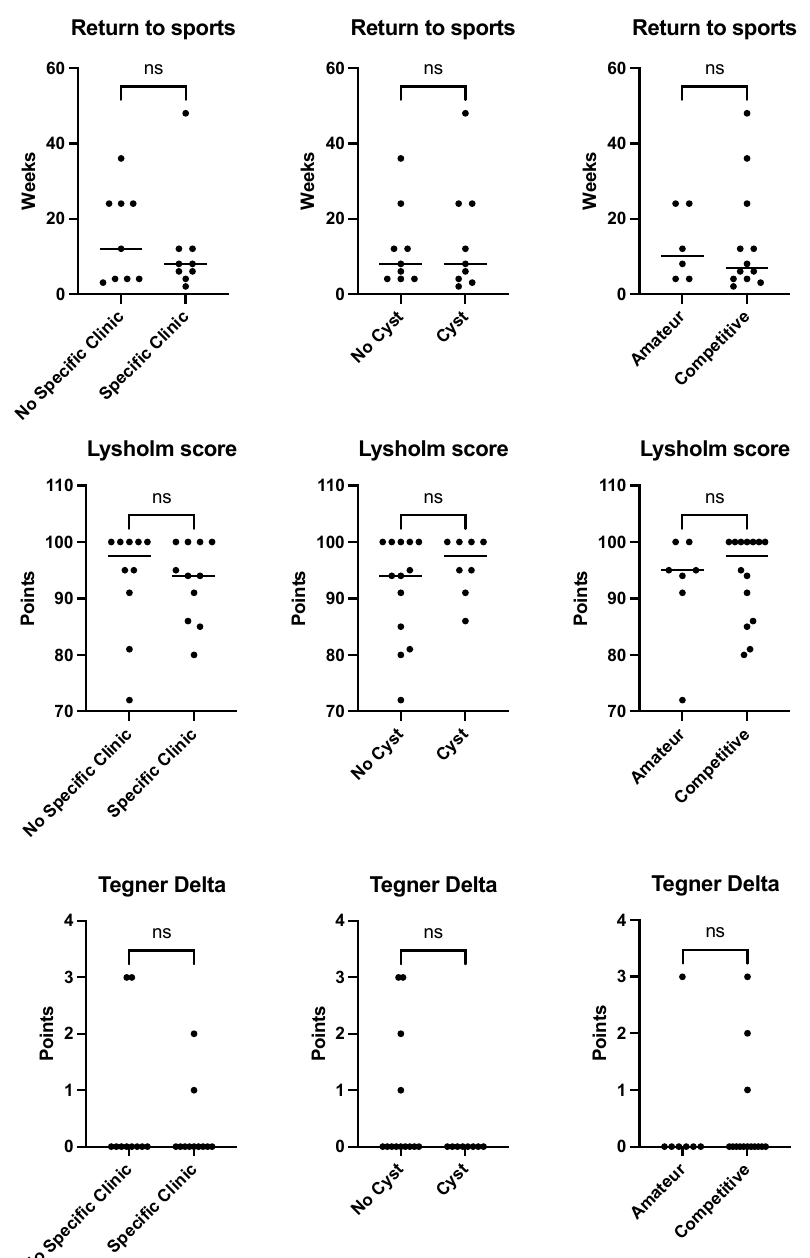
Figure 4. No influence of clinical presentation, MRI morphology of DFCI nor sports level on down- time and outcome parameters. Scatter plots. Influence of absence/presence of a specific posteromedial knee pain, paratendinous cystic lesion (MRI) or level of sports activity on time to RTS (=downtime), LS and loss of activity (TAS delta) not demonstrated in this study, p > 0.05. LS = Lysholm score; TAS = Tegner activity scale; MRI = magnetic resonance imaging. ns = not signi fi cant.